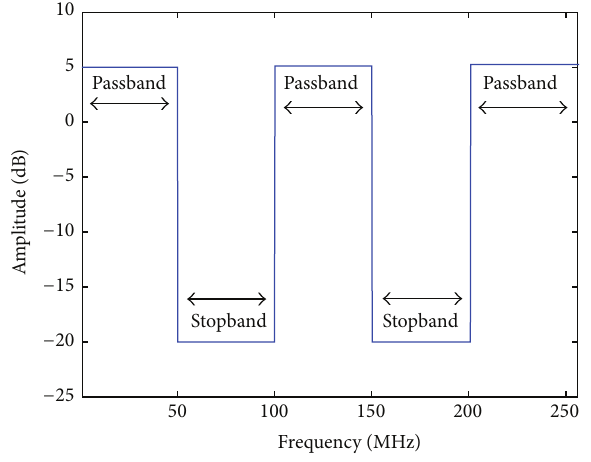
Figure 4: Ideal power spectra